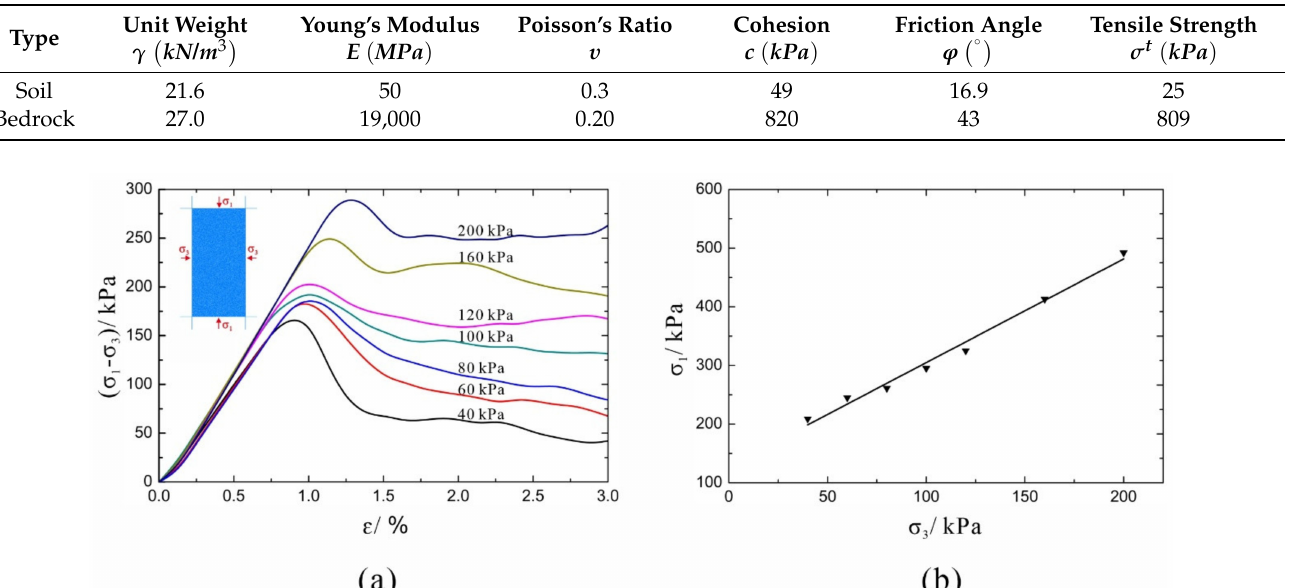
Table 1. Parameters used in numerical analyses.